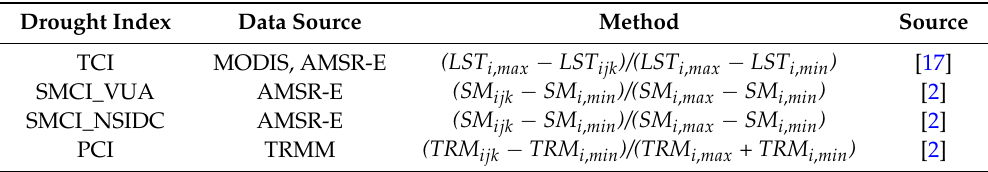
Table 2. Description of the remote sensing-based drought